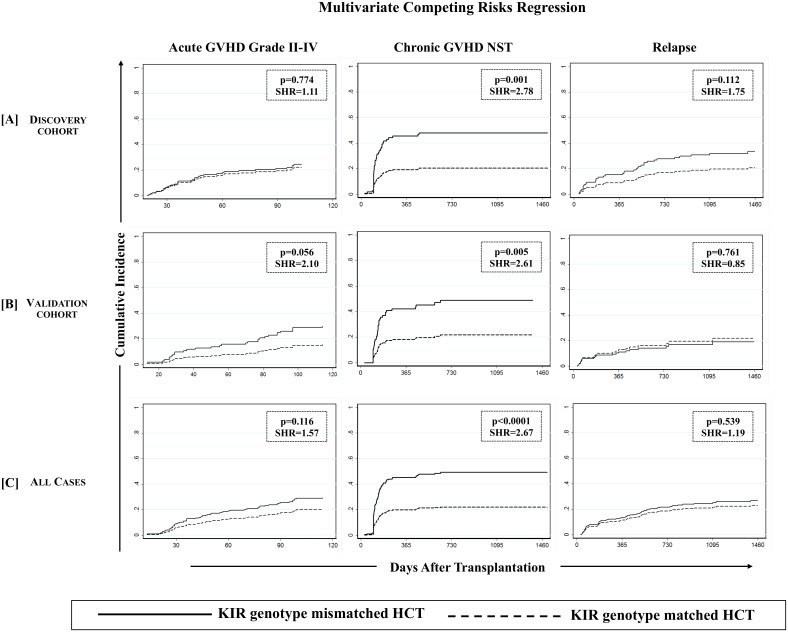
Association of KIR genotype mismatching with chronic GVHD was confirmed using a multivariate competing risks regression model.Effect of KIR genotype mismatching on aGVHD grade II-IV (left panel), cGVHD needing systemic therapy (middle panel) and relapse (right panel) was analyzed using multivariate competing risks regression model (Fine and Gray method) across discovery [A], validation [B] and combined [C] cohorts. Graft failure, relapse, second malignancy or death occurring before the onset of cGVHD was considered competing risks for cGVHD. Graft failure, second malignancy or non-relapse death occurring before the onset of relapse was considered competing risk for relapse. P values <0.05 were considered statistically significant. Favorable effect of KIR genotype matched donors on cGVHD (middle panel) was confirmed across discovery and validation cohorts in addition to all analyzed cases.